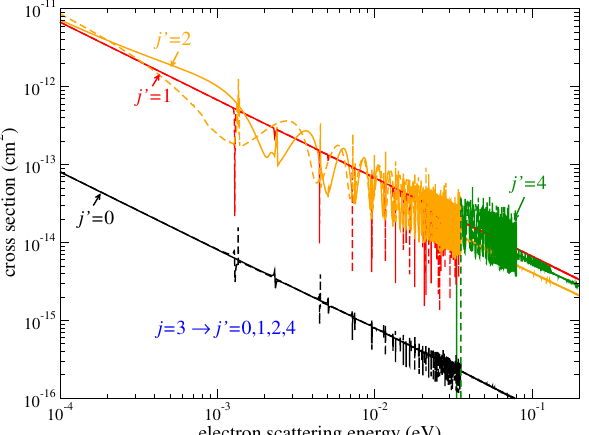
Figure 4. Cross sections of rotational (de-)excitation from the rotational level j = 3 to several other levels j (cid:48) of 4 HeH + (solid lines) and 3 HeH + (dashed